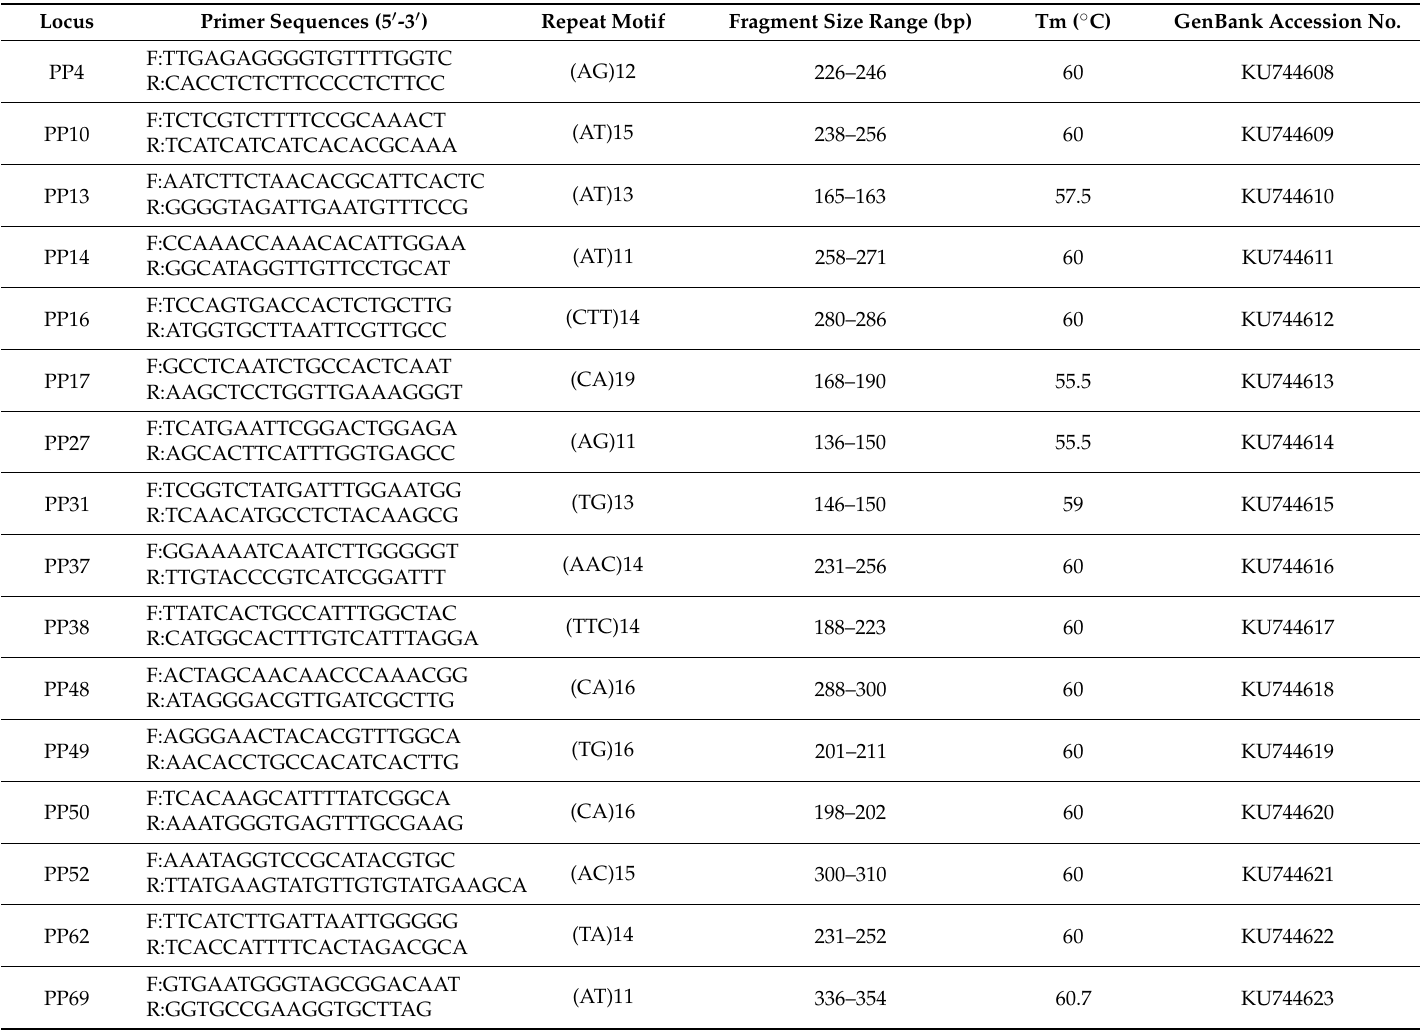
Table 1. Characteristics of 20 microsatellite loci developed in Primula poissonii